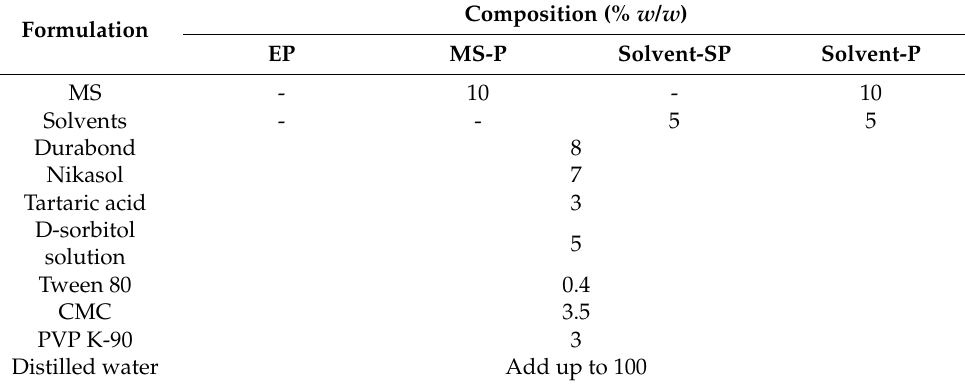
Table 1. Formulation of